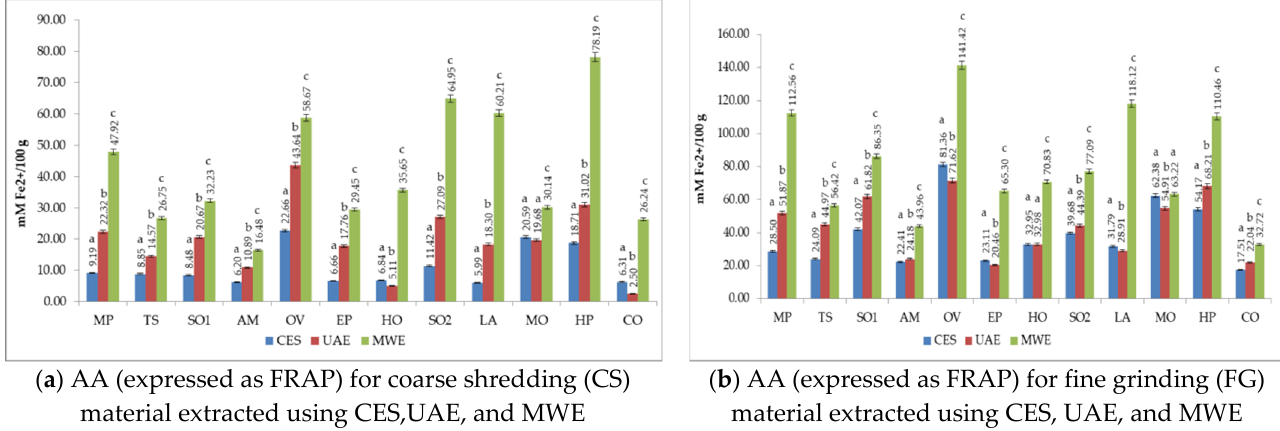
Figure 5. The AA (expressed as FRAP) compared for the 3 extraction methods ( a ) CS; ( b ) FG. According to the t -test, the different lower-case letters (a–c) represent the significant differences ( p < 0.05) between samples from the same plant obtained by different extraction methods.